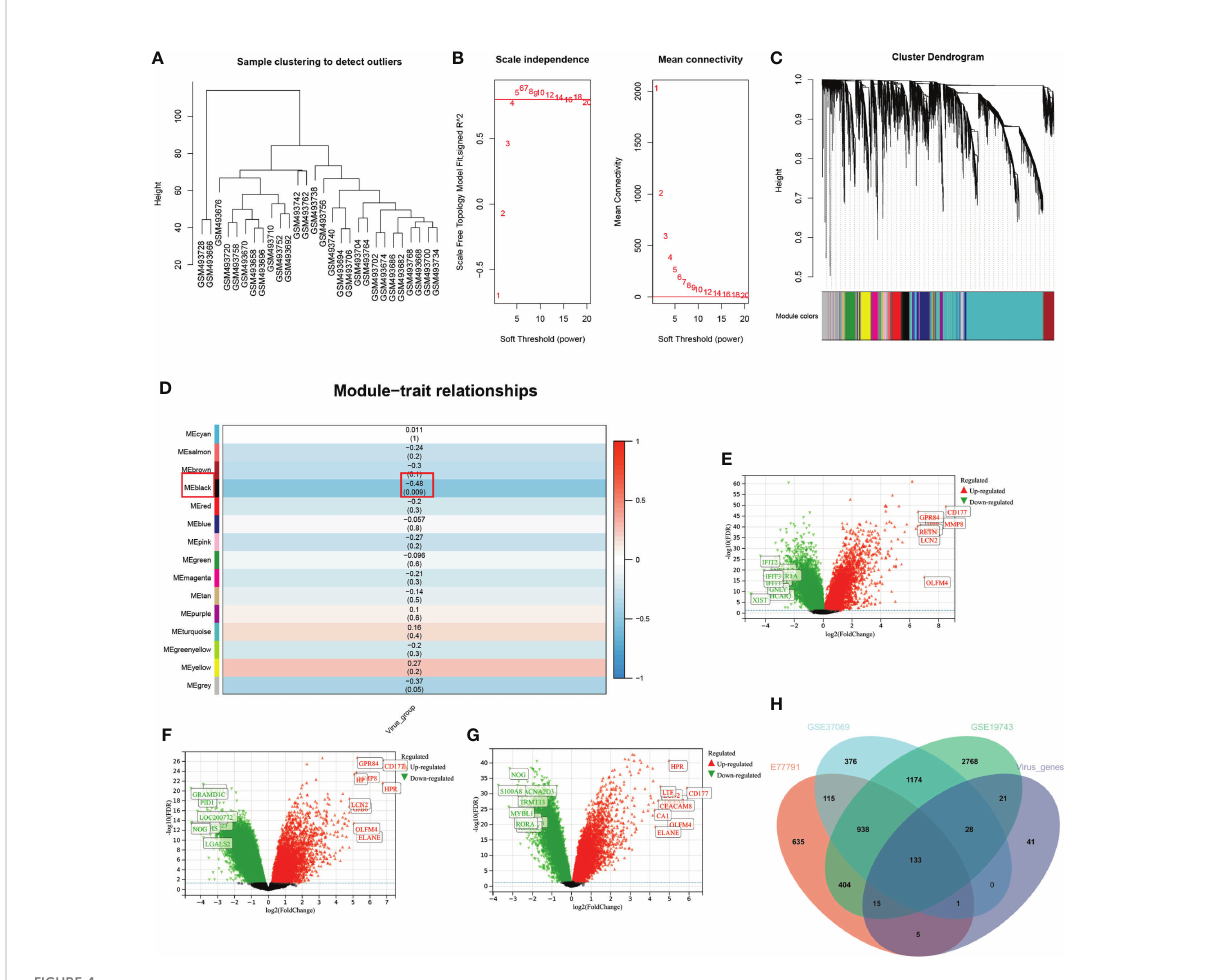
FIGURE 4 WGCNA and differential expression analysis (A) In the cluster analysis results of the GSE19743 dataset, abnormal samples can be eliminated according to the height value. (B) Analysis of scale-free fi t indices (left) and average connectivity (right) to select various soft power ( b ). Soft threshold: select the soft threshold when R2>0.85. (C) Cluster dendrogram of burn trait genes; each color below represents a co-expressed gene module. (D) Correlation of consensus clustering groupings with gene modules. The values are the correlation coef fi cients (p), respectively. Red represents positive correlation, and blue represents negative correlation. Black modules have a signi fi cant correlation with virus grouping. (E – G) . Differential expression analysis of genes in three burn datasets. Green represents down-regulated genes, and red represents up-regulated genes. The genes in black are not signi fi cantly different. (H) The intersection of the three burn datasets and the black module in